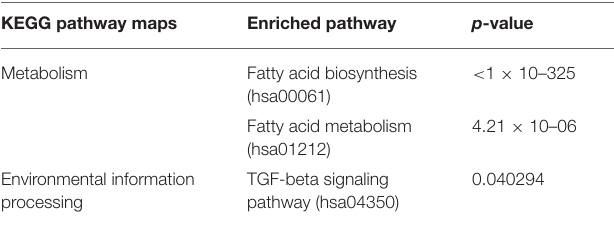
TABLE 3 | Results from the DIANA-miRPath v3.0 predictions of Kyoto Encyclopedia of Genes and Genomes (KEGG) pathways according to the differential expression microRNAs (miRNAs) between radioresistant and radiosensitive